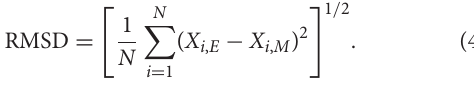
$ Model parameters are computed as the median of the bootstrap parameter distribution and bracket parameter values refer to the 2.5% and 97.5% confidence intervals on the distribution. # N, Number of samples used for model parameterization. ∗ denotes units in mgm − 3